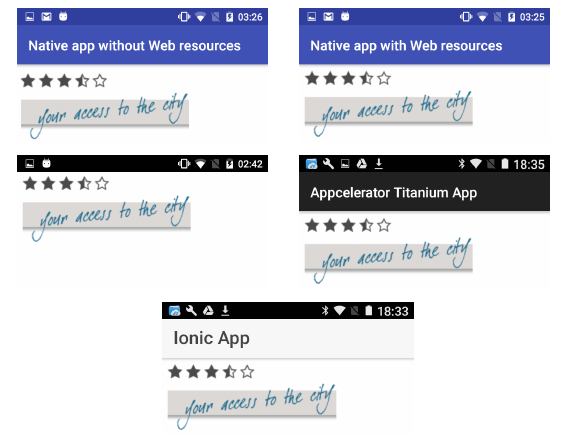
Fig. 2. Components ”group of images” and ”text images” implemented in the native application (without Web resources), native application (with Web resources), Cordova application, Appcelerator application and Ionic application,